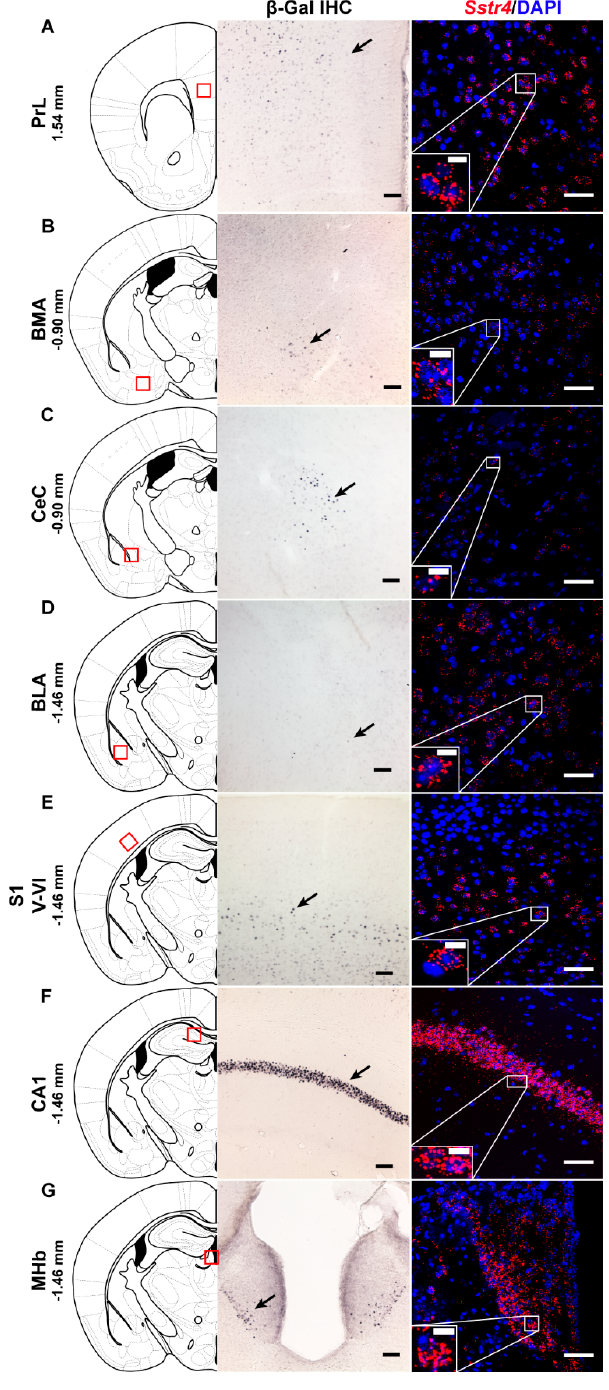
Figure 1. Representative β -galactosidase and Sstr4 mRNA expression in various mouse brain areas (by β -Gal immunohistochemistry and singleplex fluorescent RNAscope). lacZ signal from Sstr4 lacZ/lacZ mice ( N = 3, brightfield, left panels) and Sstr4 mRNA in red counterstained with DAPI from C57BL6/J (WT) mice ( N = 4, right panels) are shown in the prelimbic cortex (PrL, Bregma 1.54 mm, ( A )), in the basomedial amygdala (BMA, Bregma − 0.9 mm, ( B )), in the core of central amygdala (CeC, Bregma − 0.9 mm, ( C )), in the basolateral amygdala (BLA, Bregma − 1.46 mm, ( D )), in the layer V pyramidal neurons of the primary somatosensory cortex (S1, Bregma − 1.46 mm, ( E )), in the CA1 of hippocampus (CA1, Bregma − 1.46 mm, ( F )), and in the medial nucleus of habenula (MHb, Bregma − 1.46 mm, ( G )). Scale bar: 50 µm, inset scale bar: 10 µm.